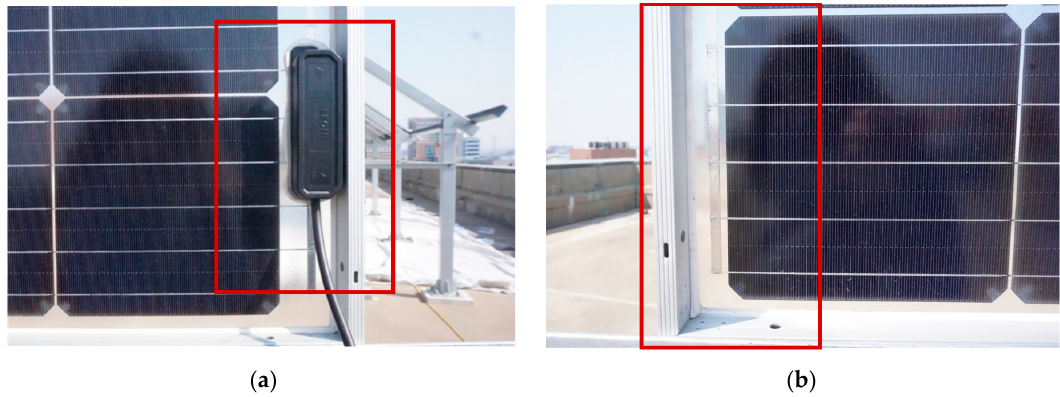
Figure 6. Shadows on the rear surface at a specific time: ( a ) shadow on the rear-surface for the east (front)-west orientation at 14:30 p.m.; ( b ) shadow on the rear-surface for the west (front)-east orientation at 12:30 p.m.